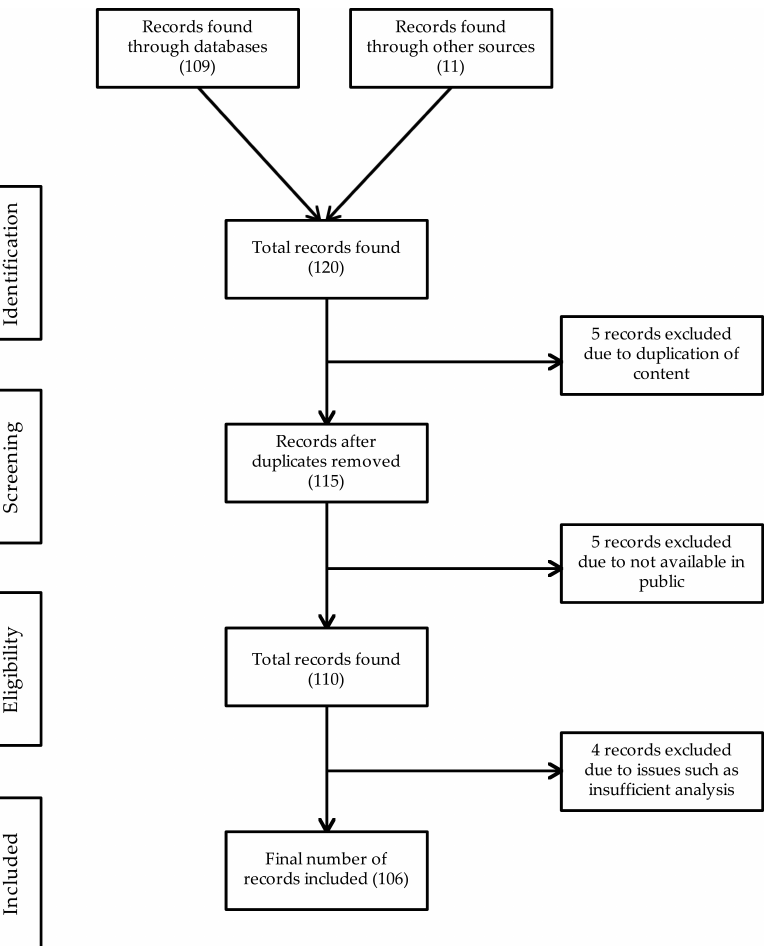
Figure 2. PRISMA method: collection of papers for the